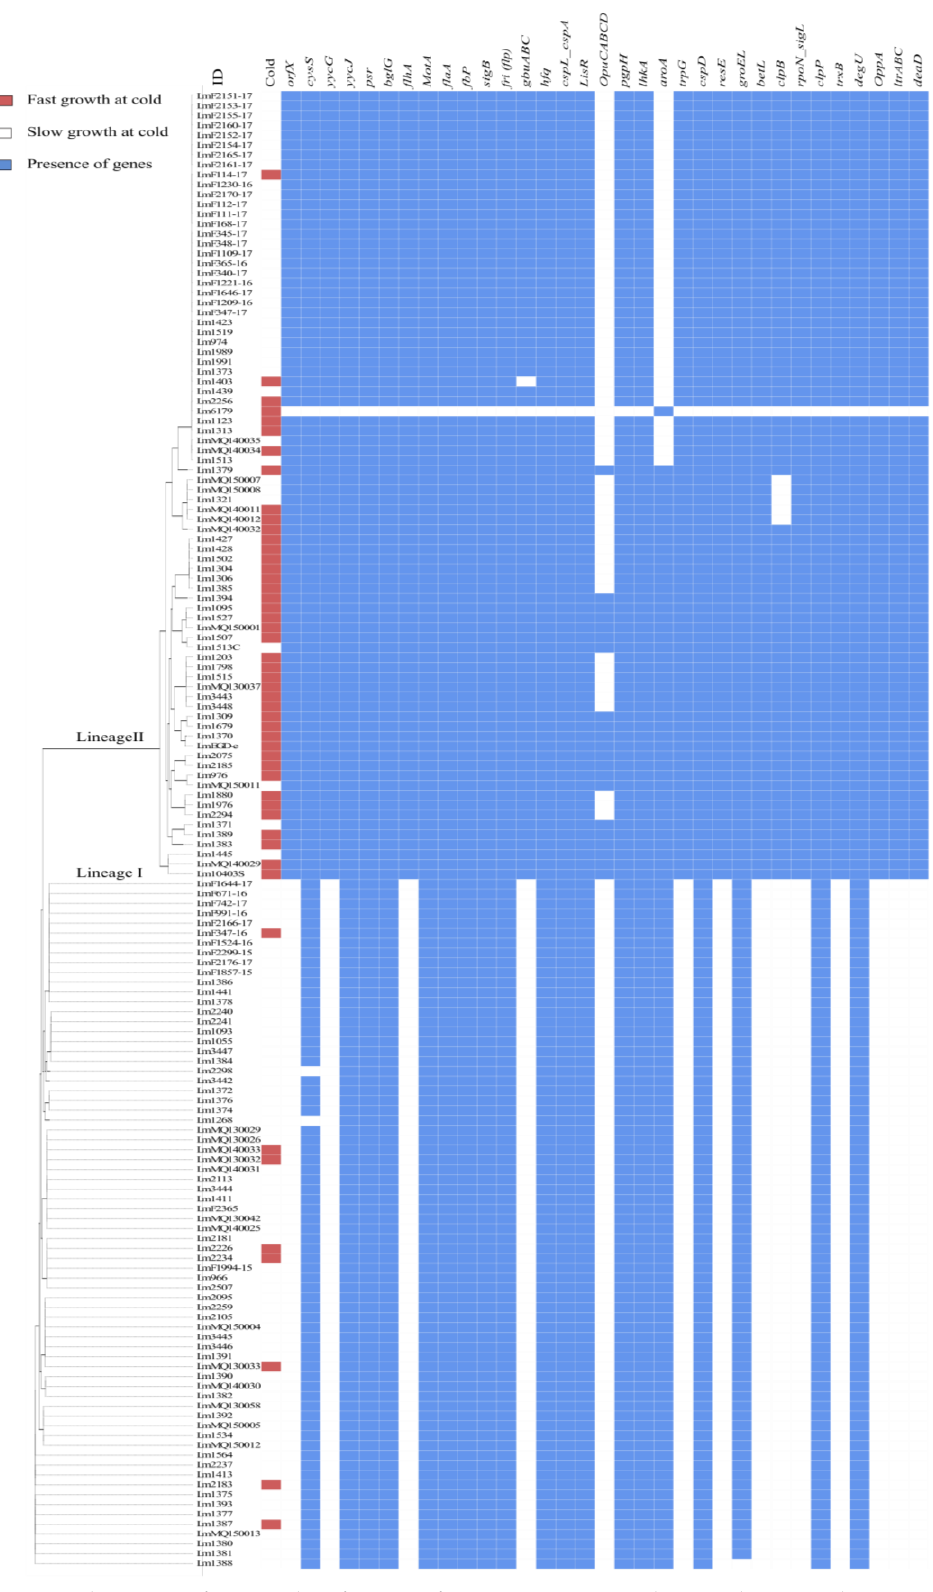
Figure 4. Alignment of MLST classification of L. monocytogenes isolates and BLAST determined the presence (cutoff > 95% nucleotide identity) of previously identified stress tolerance loci in L. monocytogenes in red (presence) or white (absence). The cold temperature growth profile of the isolates is also indicated with orange (fast) or purple (slow) bars.